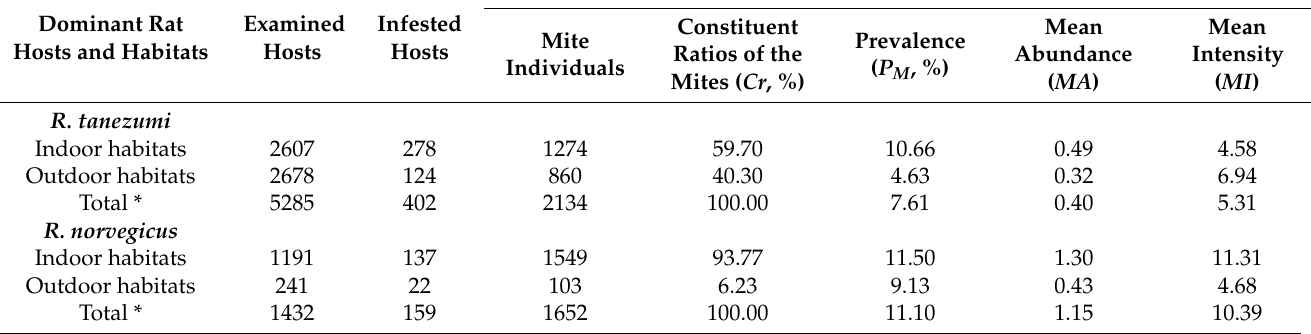
Table 8. Infestations of R. tanezumi and R. norvegicus rats with O. bacoti mites in different habitats of Yunnan Province, Southwest China